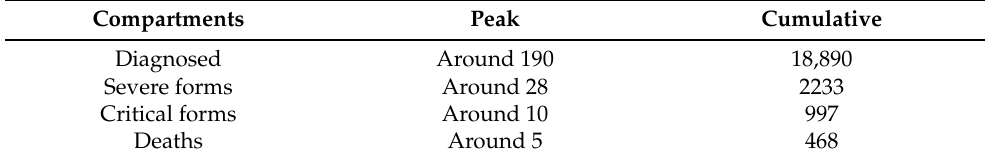
Table 2. Estimated peaks and cumulative of diagnosed cases, severe forms, critical forms and